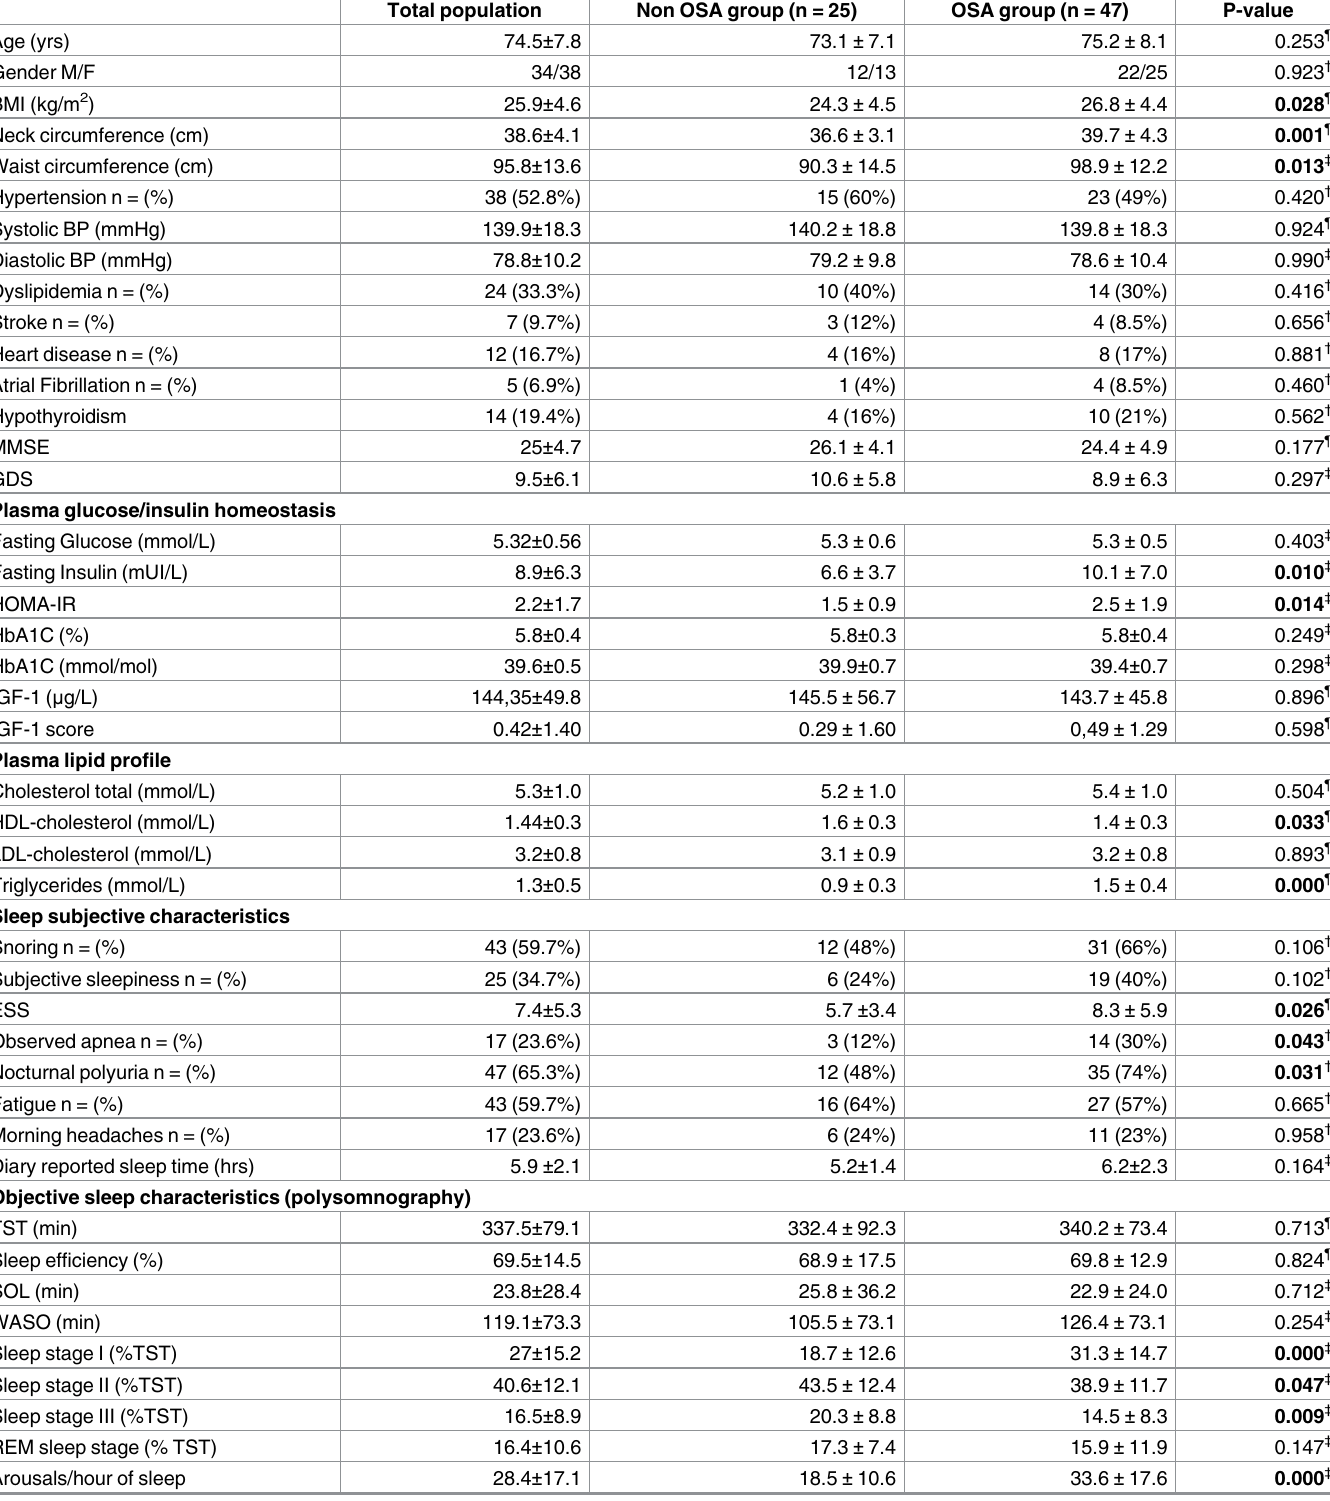
Table 1. Patients’